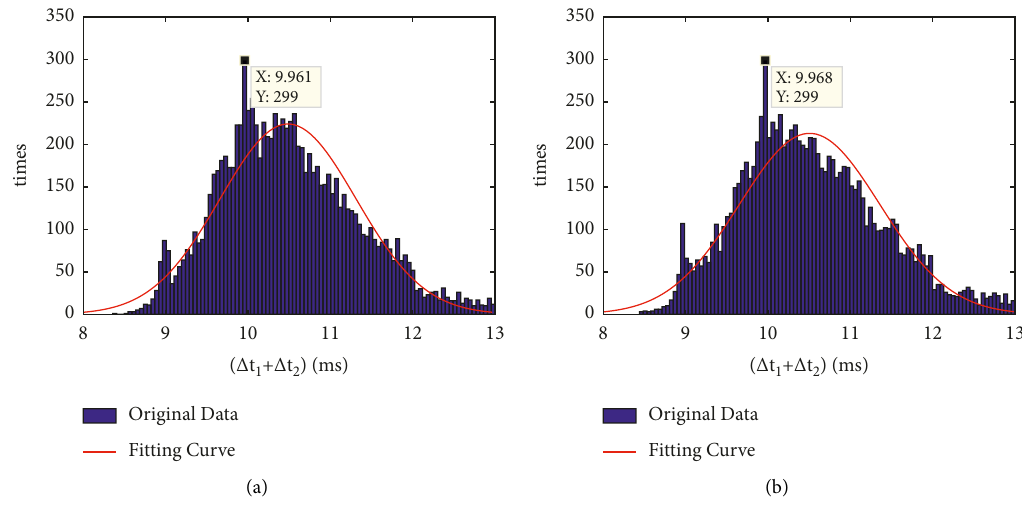
Figure 4: Distribution of 10,000 random data delays. (a) The first set. (b) The second set.